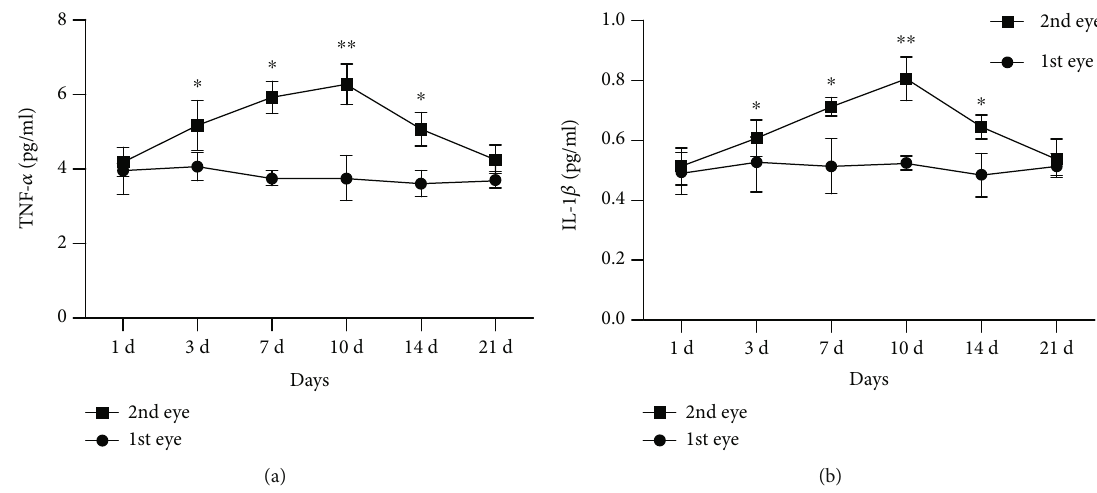
Figure 5: Concentrations of TNF- α and IL-1 β in AH of both eyes during bilateral cataract